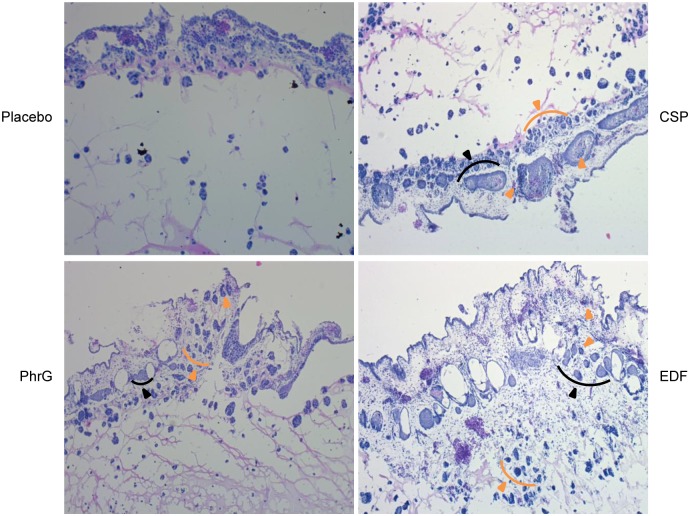
Histological H&E evaluation of the chorioallantoic membrane (CAM).Placebo sample serves as negative control. Tumour cells, when treated with the quorum sensing peptides, moved through the chorionic layer into the mesoderm (orange arrowheads). Clusters of chorionic epithelial cells are indicated by black arrowheads, indicating aggressive tumour cell invasion through the membrane.